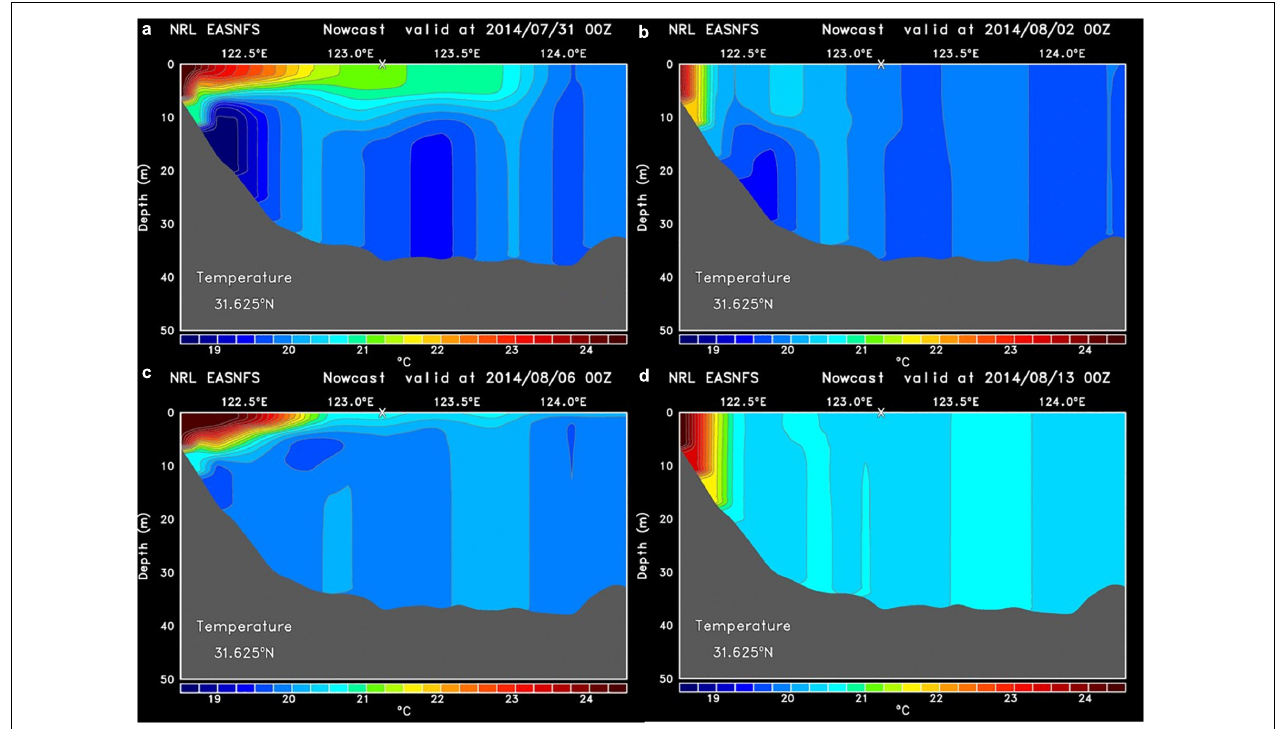
FIGURE 9 | Temperature profiles along 31.625 ◦ N transect predicted by East Asian Seas Nowcast/Forecast System (EASNFS): (a) At the end of July 2014, the water was well stratified with a 5–10-m warm layer on the top. (b) At the onset of Typhoon Nakri, the water column became well mixed. (c) After the passing of the typhoon, the water was weakly restratified. (d) Tidal mixing was able to fully mix the water column under weak stratification.